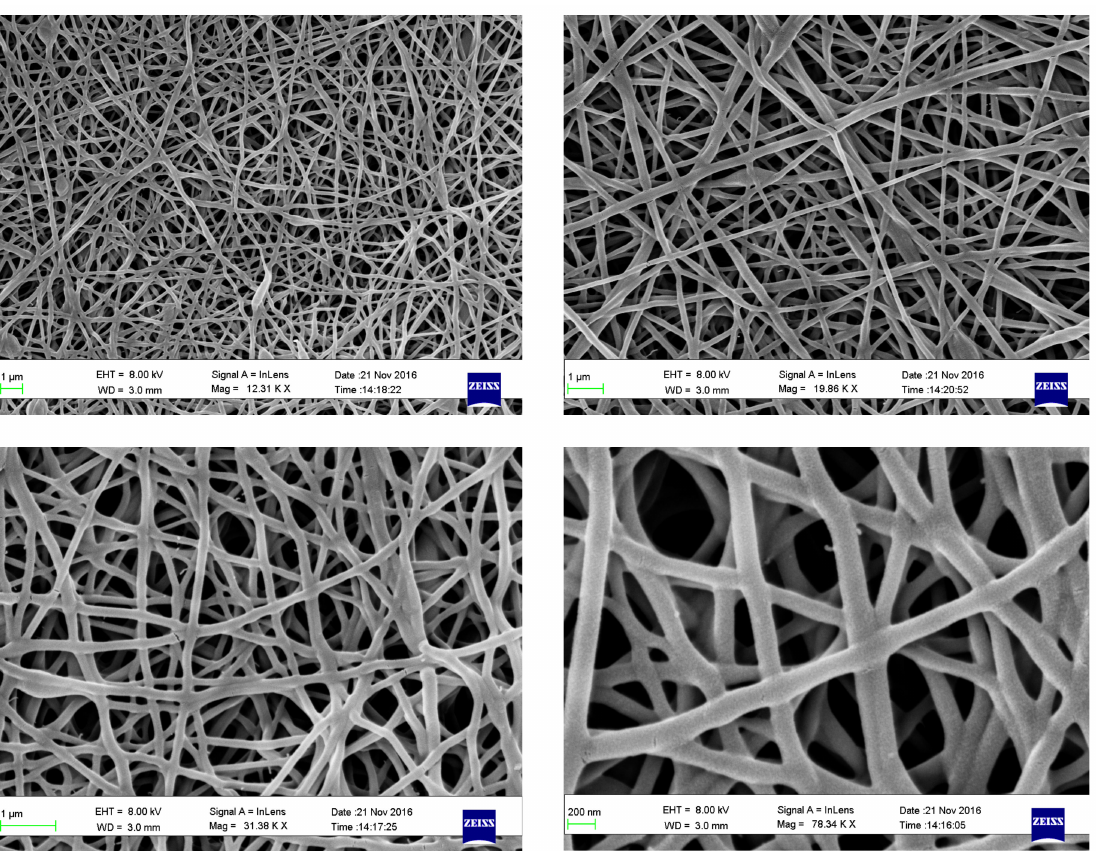
Figure 6. Scanning electron micrograph of nanofibers, showing uniform structure and diameter